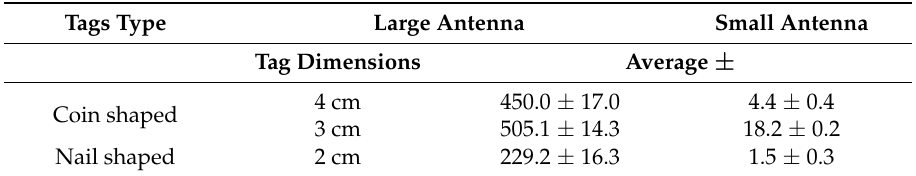
Table 1. Mean ( ± Standard Deviation) higher distance measurement calculated from both the long-range and the portable antenna for both circular (4 and 3 cm) and nail (2 cm) shaped tag.